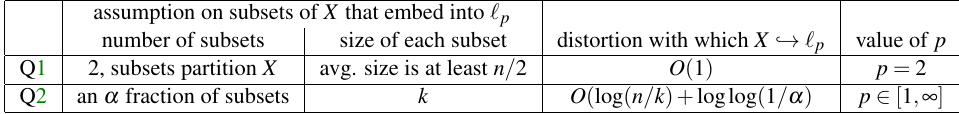
Figure 1: Comparison of the assumptions and guarantees for Questions 1 and